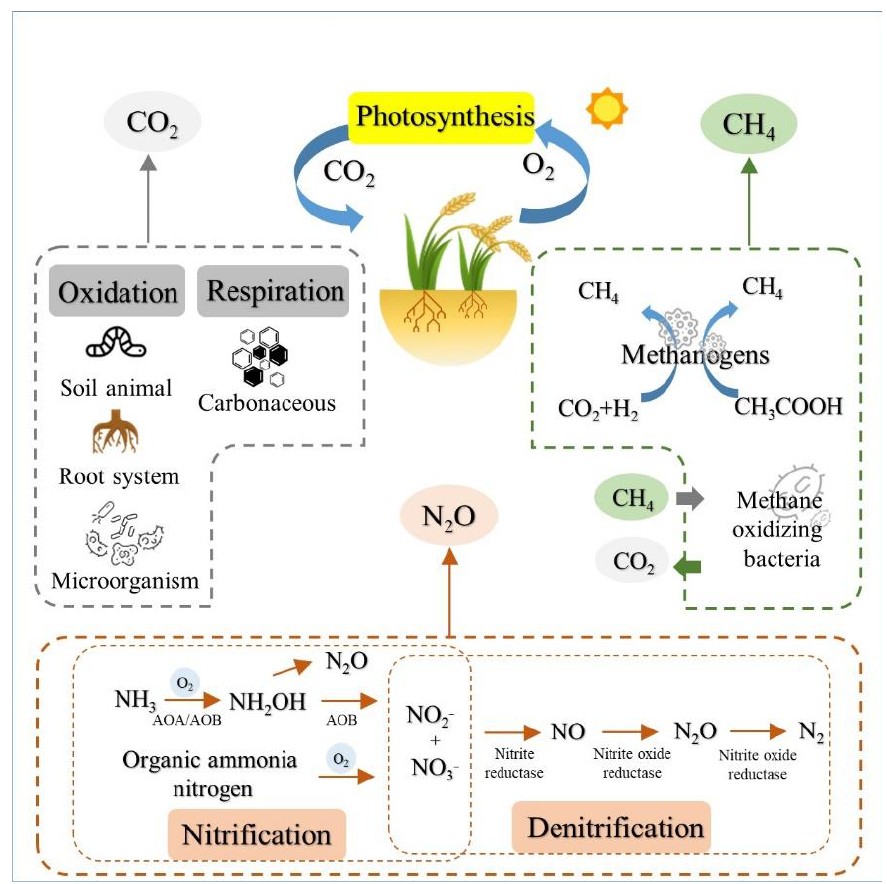
Figure 1. The production process of CO 2 , CH 4 and N 2 O in farmland soil.